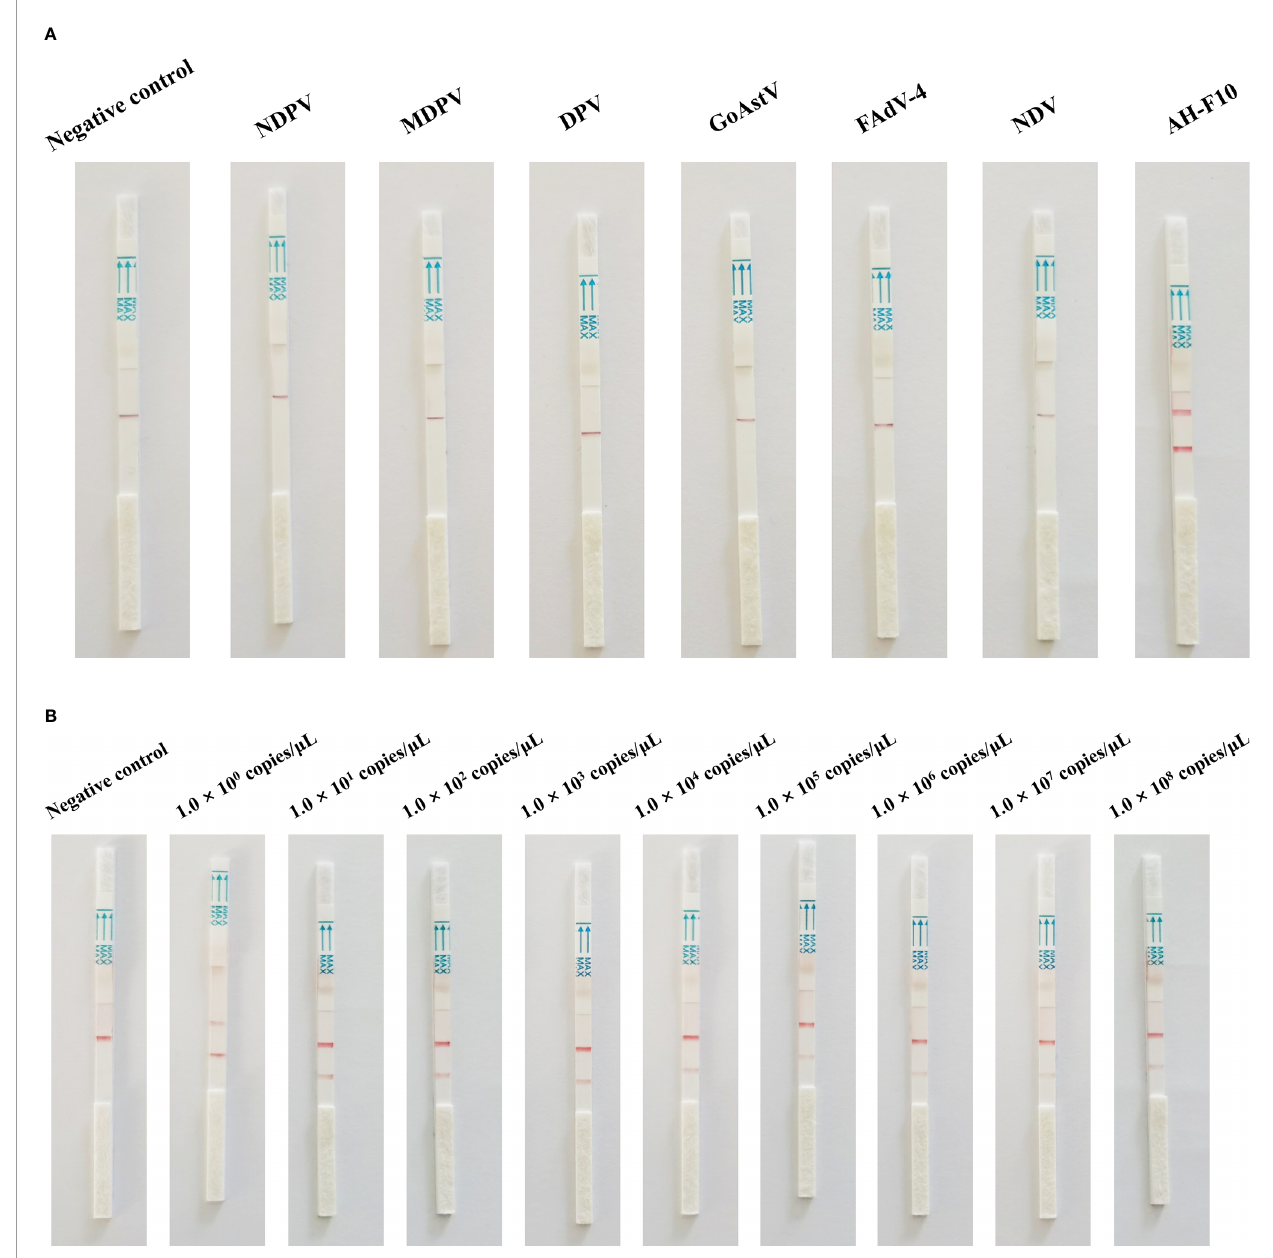
FIGURE 3 | Speci fi city and sensitivity of Cas13a lateral fl ow detection. (A) Speci fi city of Cas13a lateral fl ow detection. (B) Sensitivity of Cas13a lateral fl ow